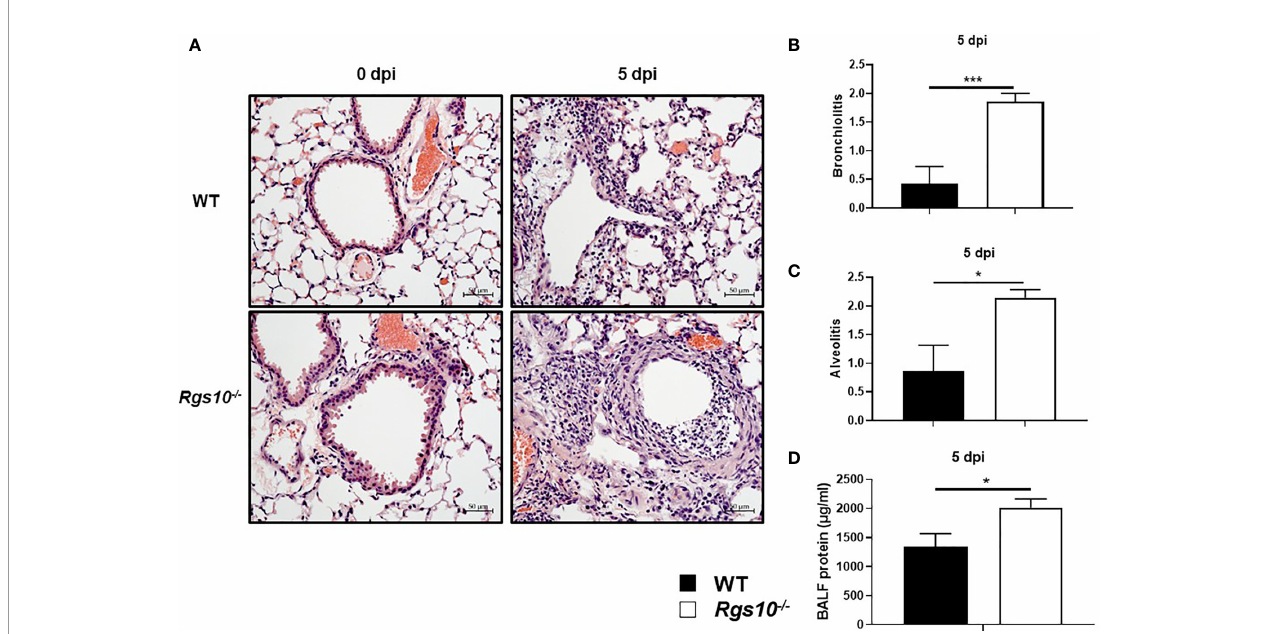
FIGURE 2 | Rgs10 de fi ciency promotes severe lung damage during IAV airway infection. Lung histopathological changes and BALF protein concentrations were evaluated in uninfected (0 dpi) WT and Rgs10-/- mice (n=5) or WT and Rgs10-/- mice (n=7) infected intranasally with 100 PFU of PR8 virus at 5 dpi. (A) Paraf fi n- embedded lung sections from WT and Rgs10-/- mice at 0 (uninfected) and 5 dpi were stained with hematoxylin and eosin (scale bar=50 m m). Representative images of at least fi ve similar results are shown. Lung histopathological scores were assessed in or around bronchioles (bronchiolitis) (B) or alveolar spaces (alveolitis) (C) . (D) Total protein concentrations in BALFs of WT and Rgs10-/- mice were determined at 5 dpi. Data were analyzed for statistical differences using unpaired t-test between groups. Data are presented as mean ± SEM where *p < 0.05; ***p <